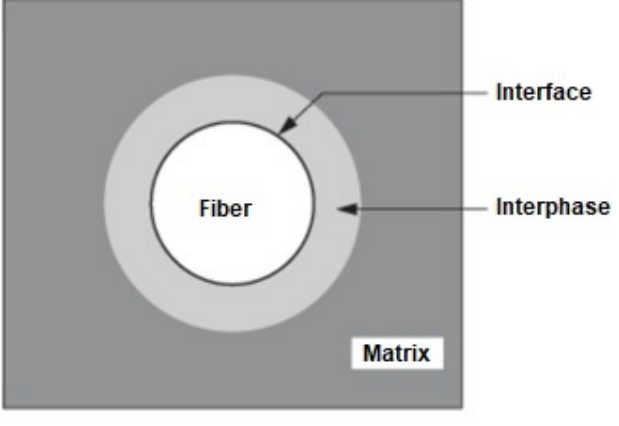
Figure 2. Interface and interphase concept [103].